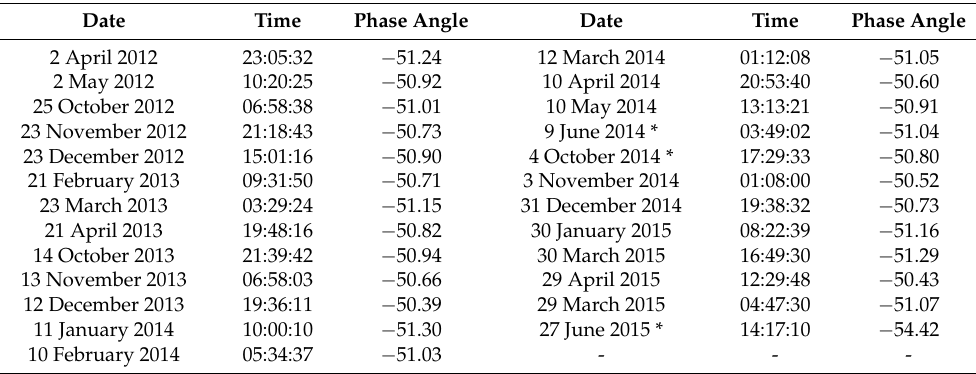
Table 1. The scheduled moon data collection information for